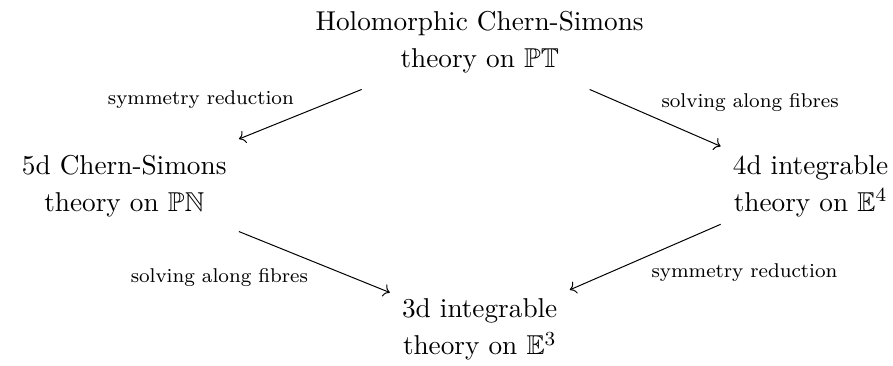
Figure 3 . A guide the relationship between CS type theories and integrable systems in dimensions 3 and